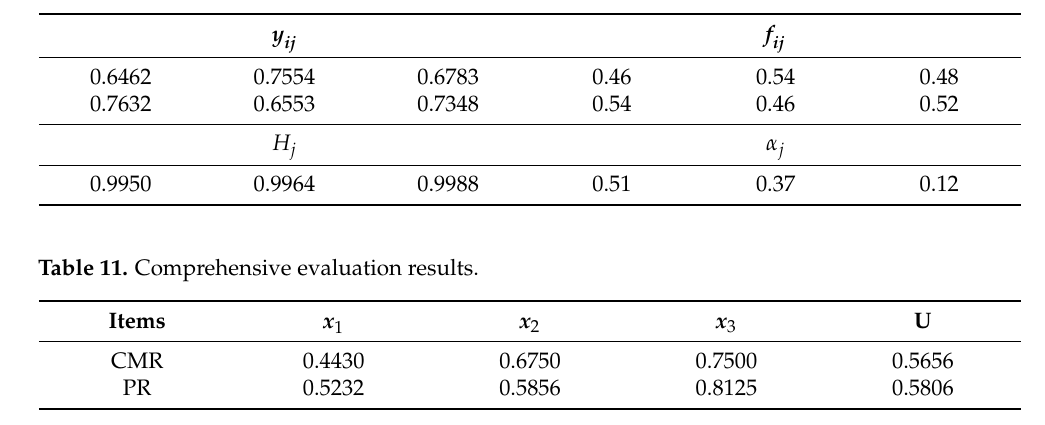
Table 10. Entropy weight analysis method for weight.